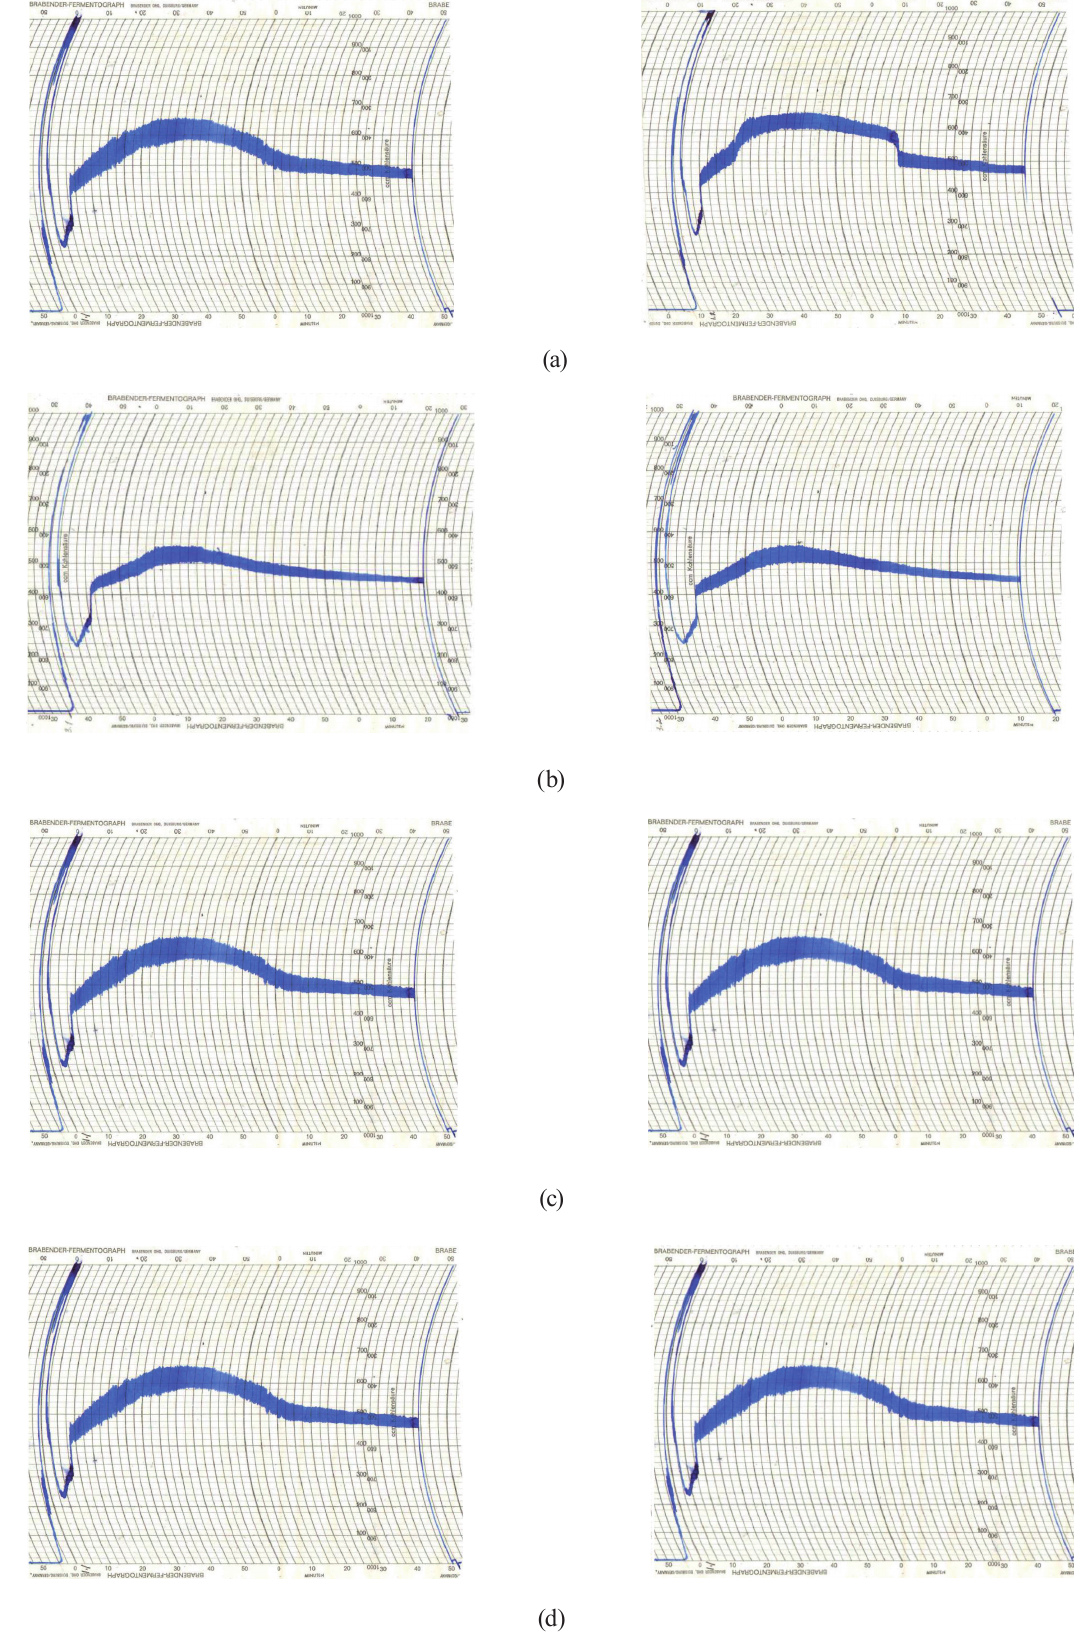
Figure 8 Valorigrams of flour mixtures with a ratio of wheat flour and amaranth extrudate of: a) 90:10; b) 85:15; c) 80:20; d) 70:30. Left – replication No. 1, right – replication No.